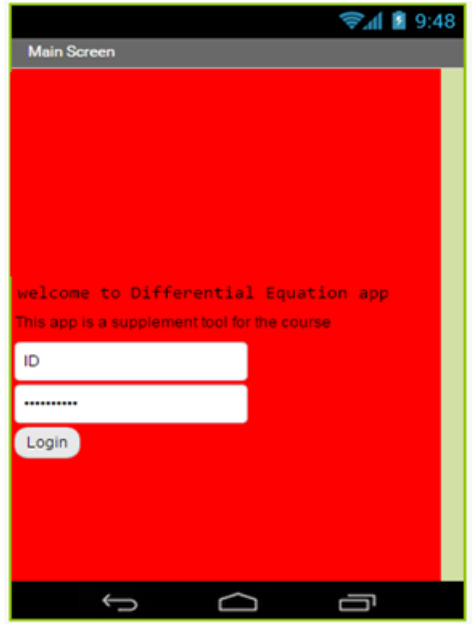
Fig. 2. Main screen of our application